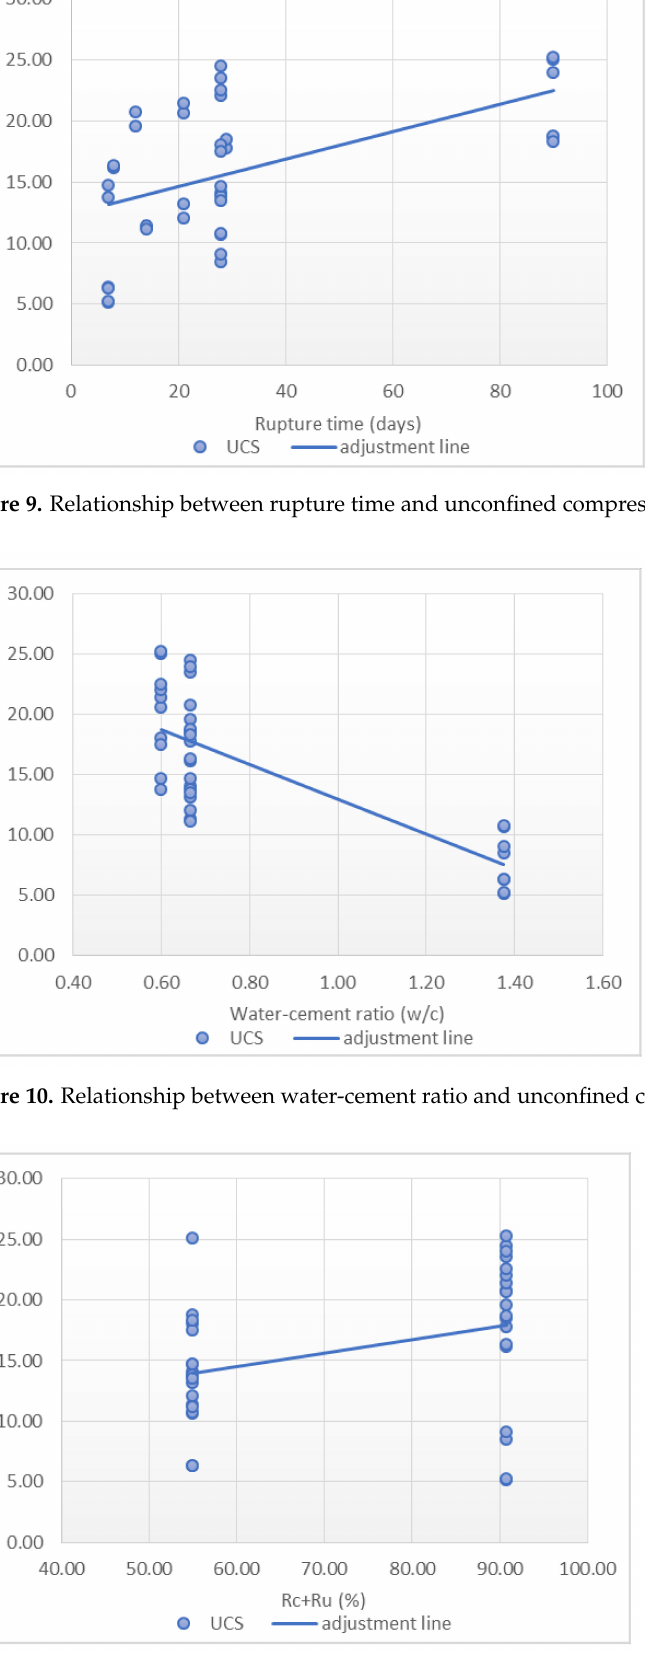
Figure 11. Relationship between Rc + Ru and unconfined compressive